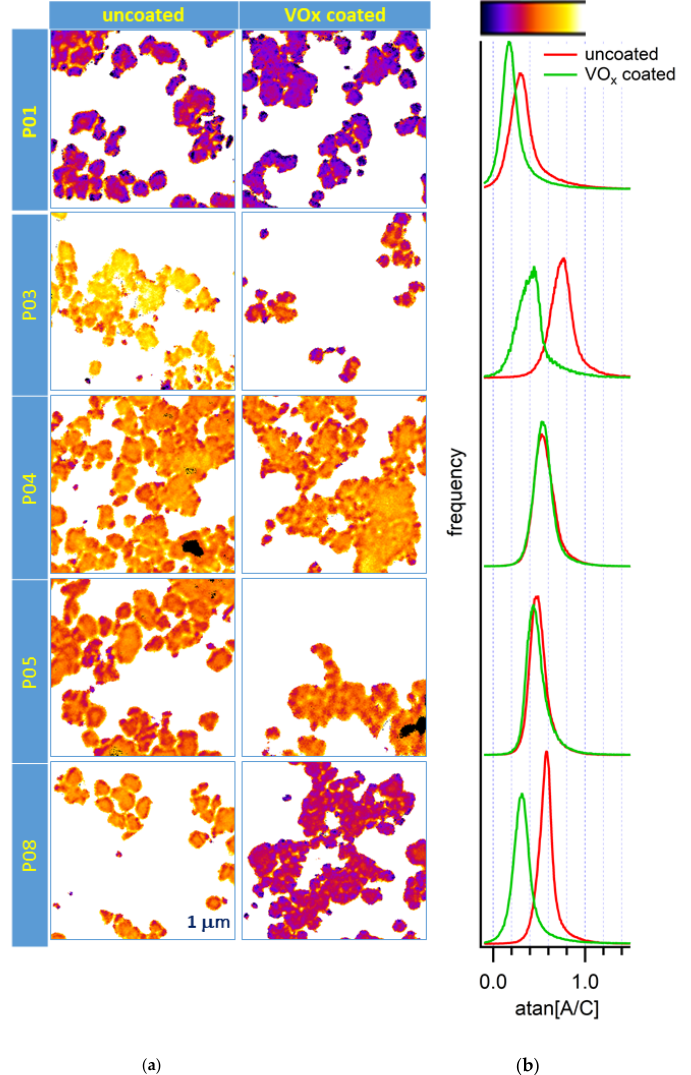
Figure 5. Distributions of A vs. C components, represented as arctan(C/B) , in the O-K absorption of the studied sample set: ( a ) 2D-maps; ( b ) corresponding area-normalized histograms. Regions of high absorbance have been masked in black to avoid consideration of possible artifacts.